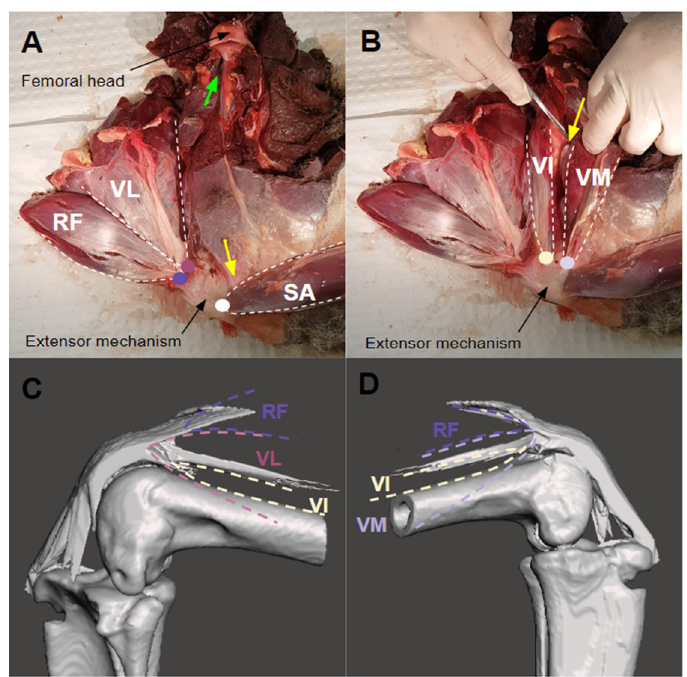
Figure 5. ( A ) Medial view: SA reflected from the RF to visualise the deep muscles underneath. Extensor mechanism insertion of the VM marked by the yellow arrow, and the femoral attachment point of the VM marked by the green arrow, originating from the lesser trochanter. ( B ) VM sits superficial to the VI. Medial intermuscular septum (yellow arrow) separates the VM and VI. ( C ) Lateral and ( D ) medial views of the representative insertions of the RF, VL, VI and VI muscles. Colour coded insertion points are also marked on ( A , B ).